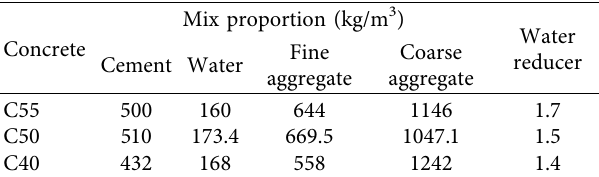
Table 2: Mix proportion of concrete.